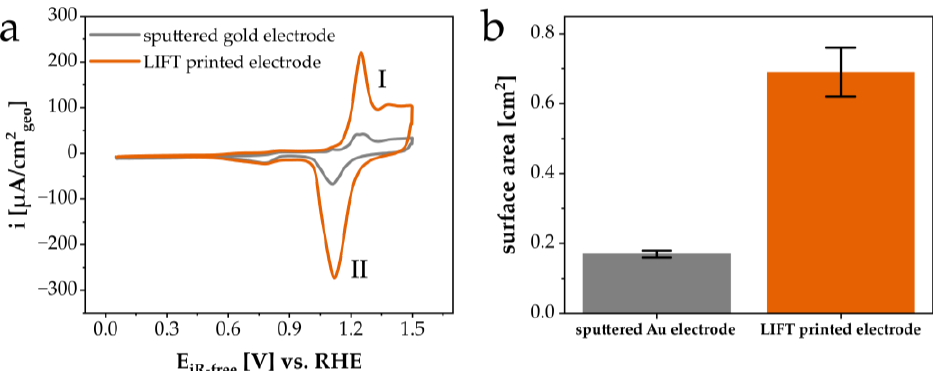
Figure 9. ( a ) Cyclic voltammetry (CV) profiles and ( b ) the corresponding electrochemically active surface areas (SA) of the LIFT-printed gold electrode (orange) and sputtered gold electrode (grey). The CV profiles were recorded at a scan rate of 50 mV/s in Ar-saturated 0.1 M KOH.